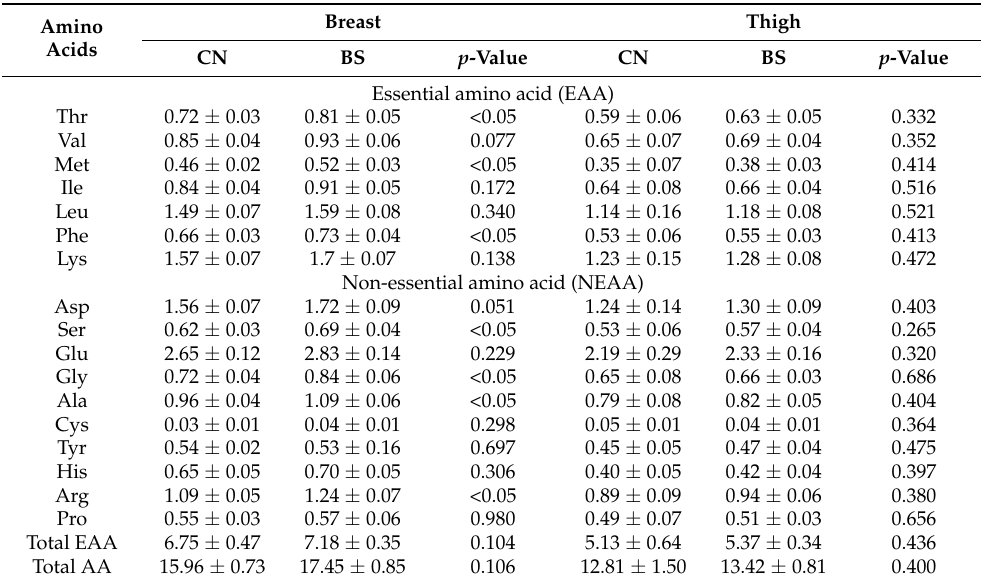
Table 6. Effects of dietary Brevibacillus laterosporus S62-9 on the amino acid content of chicken meat (g/100 g chicken meat).